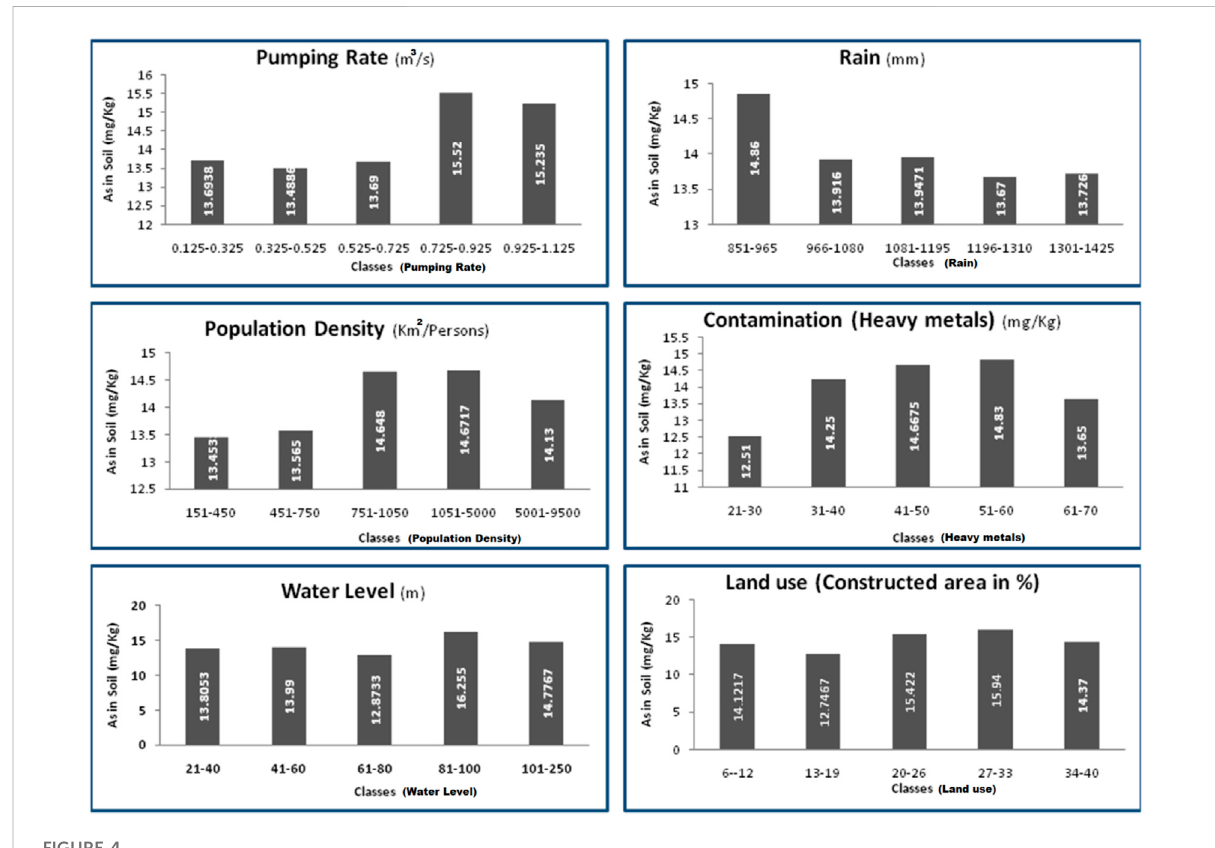
FIGURE 4 Factor classi fi cations and average arsenic concentration of each class in